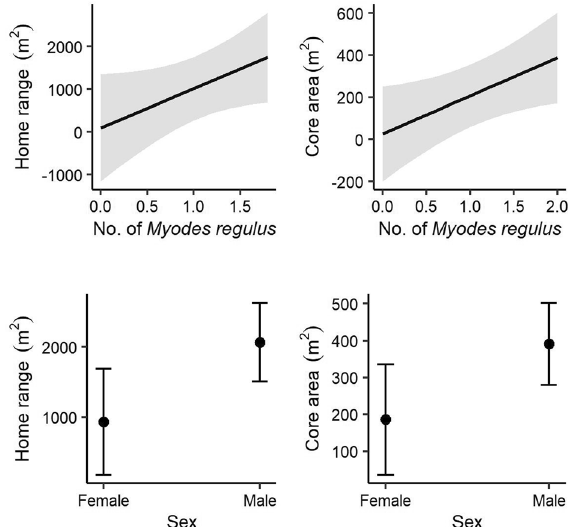
Figure 5. Demographic effects on the home range and core area of red-backed voles ( Myodes regulus ) determined by the linear